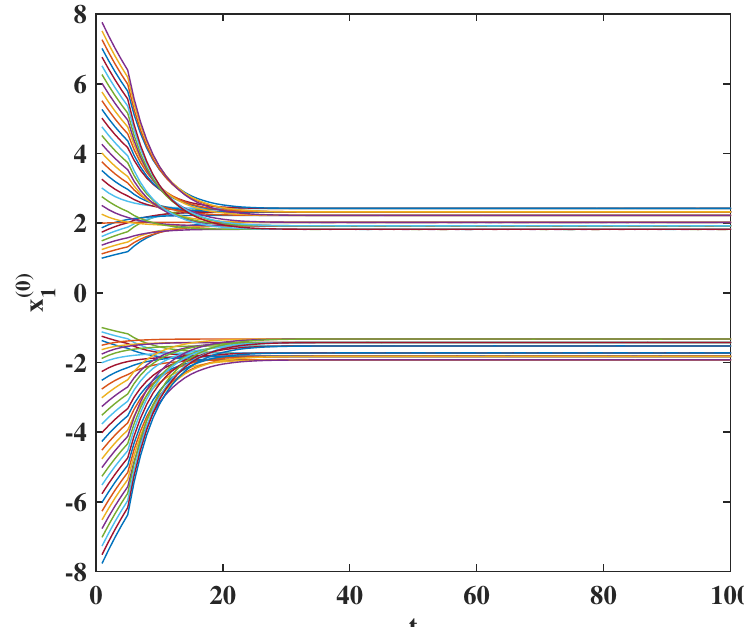
( 0 ) for system (22). 1